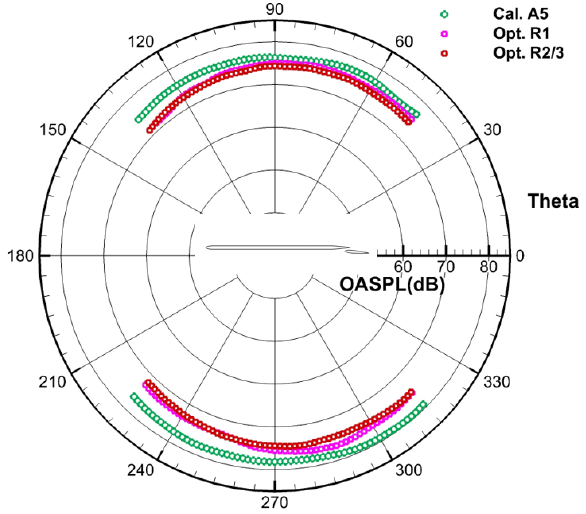
Figure 21. Comparison of far-field noise before and after optimization.